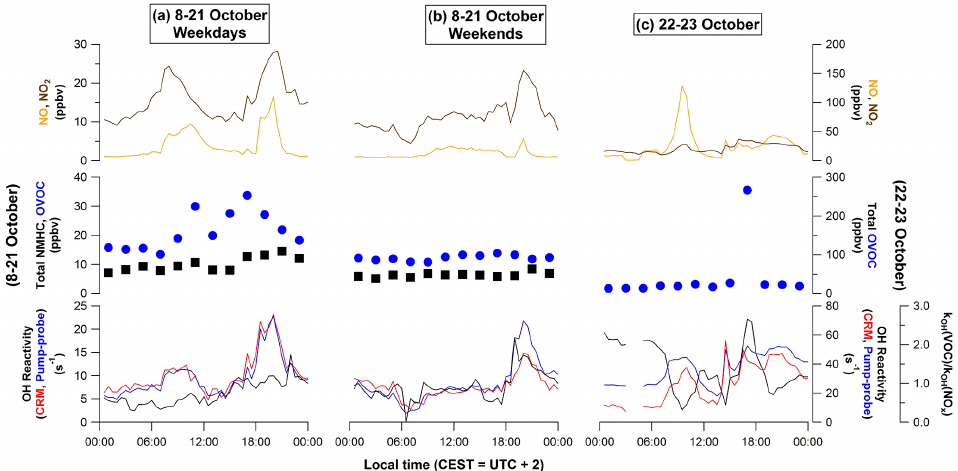
Figure 6. Diel averages of NO and NO 2 mixing ratios (top panels), and total NHMC and OVOC mixing ratios (middle panels). Measured OH reactivity values (bottom panels) for (a) weekdays from 8 to 21 October, (b) weekends from 8 to 21 October, and (c) from 22 to 23 October are shown as lines. Note that the scale for (a) and (b) is displayed on the left y axes, and the scale for (c) is displayed on the right y axes. The averaging period for all data is 30min, except for NMHC and OVOC mixing ratios, which are averaged over a period of 90min. Also note the absence of NMHC data for 22–23 October due to a failure of one of the GC instruments (see text).